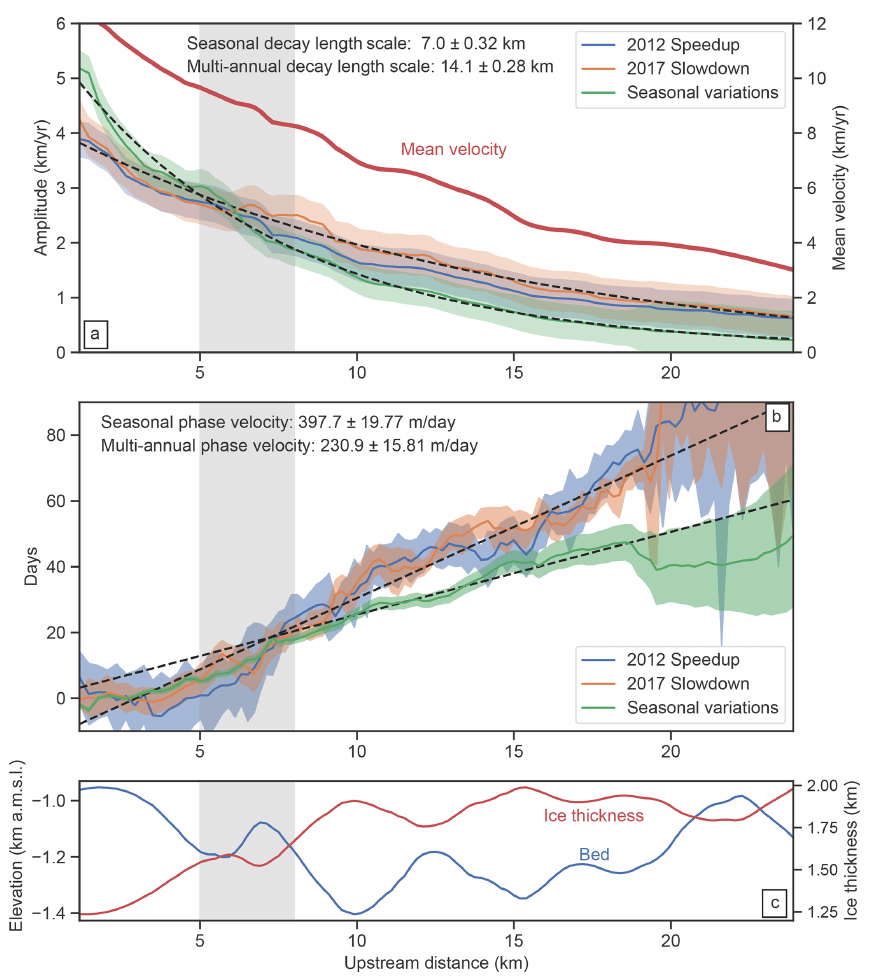
Figure 3. Glacier centerline transects of phase delay and velocity variation amplitude for the seasonal, 2012 speedup, and 2017 slowdown signals compared to centerline ice thickness and bed depth. (a) Velocity variation amplitude and 1SD (standard deviation) uncertainties for the three different signals. The decay length scale ( e -folding distance) for the multi-annual signals is roughly twice that of the seasonal signal (represented by best-fit exponential decay model in dashed black lines). Dark-red line corresponds to the mean velocity magnitude along the centerline (note the 2 × scaling factor for the mean velocity axis). (b) Relative phase delay for the three different signals: seasonal phase delay – green; 2012 speedup - blue; 2017 slowdown – orange. The upstream centerline distance is with respect to the intersection of the centerline and the 2017 terminus. For distances greater than 8km upstream, the phase velocity for the seasonal signal is roughly twice as fast as the phase velocities for the multi-annual transients (represented by dashed black lines). The shaded areas represent the 1SD formal uncertainties for the annual phase (green) and bootstrapped standard deviation for the transients (blue and orange). (c) Centerline ice thickness (red) and bed depth (blue) using bed data from BedMachine V3 (Morlighem et al., 2017). For all plots, the gray-shaded region represents the upstream region encompassed by the southern